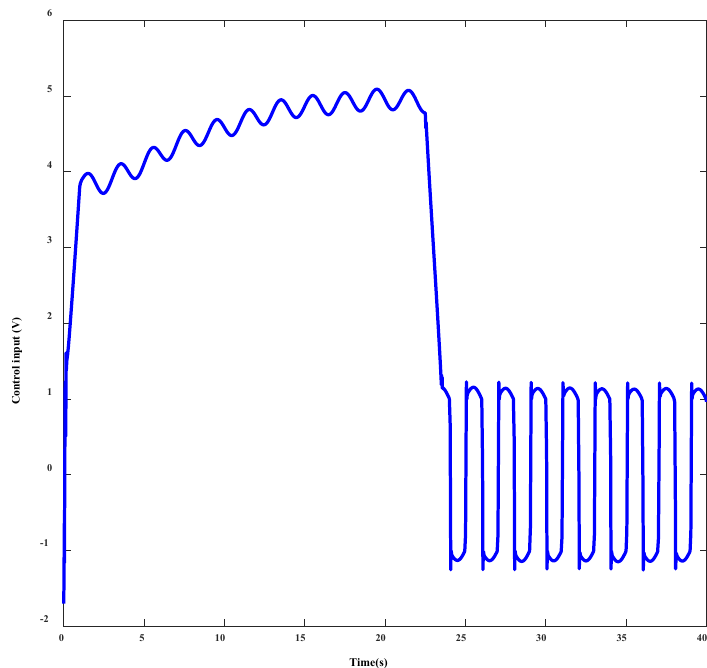
Figure 7. The disturbance estimations of the ADRAC.